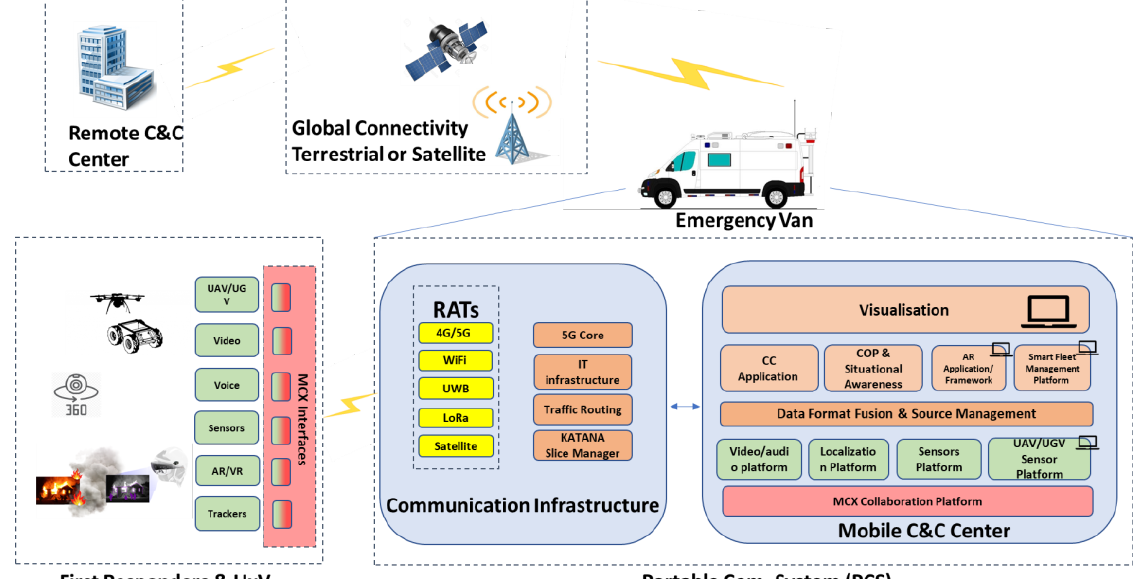
Figure 1. Overview of the system architecture.